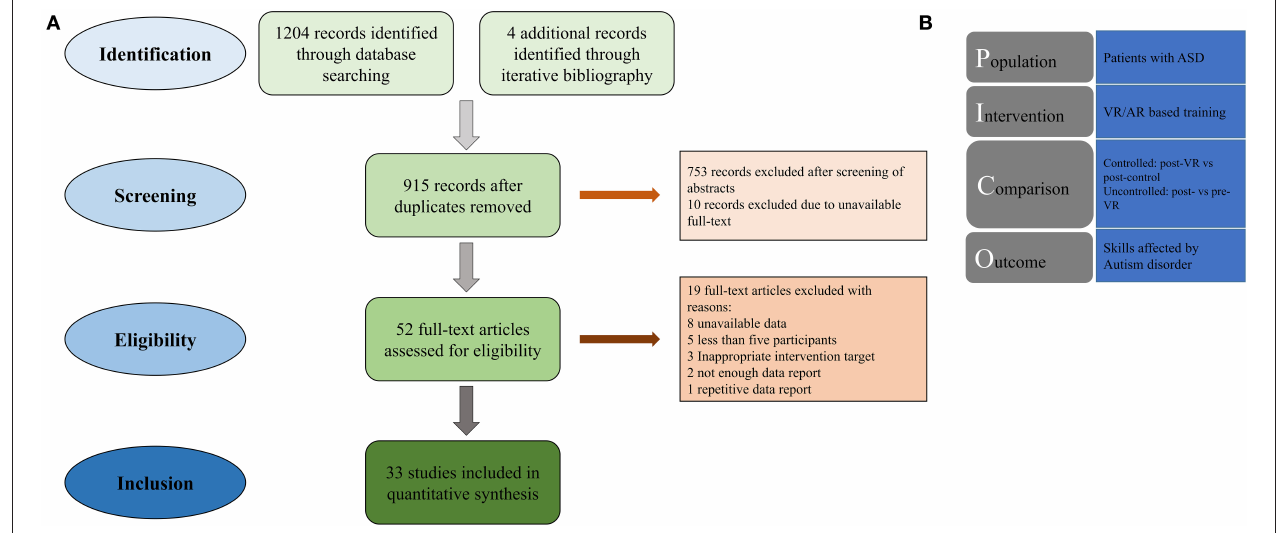
FIGURE 1 | (A) Flow diagram of study selection and identification process. (B) Schematic presentation of PICO for this